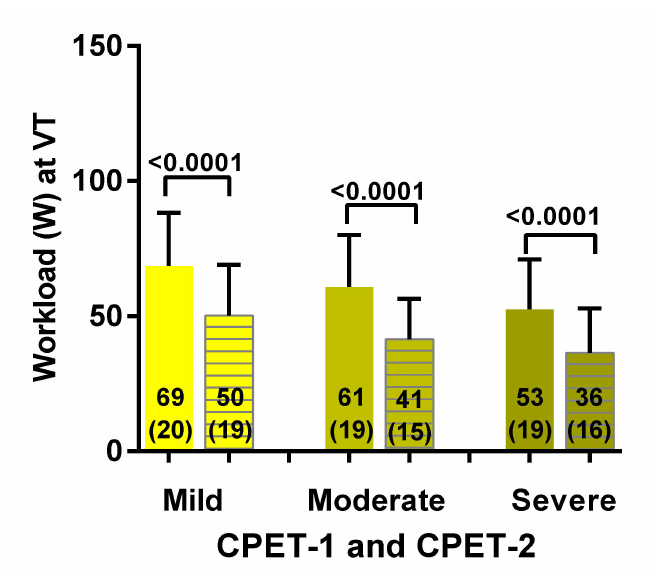
Figure 4. Workload at the ventilatory threshold for both CPET-1 and CPET-2 for mild, moderate and severe ME / CFS patients. CPET: cardiopulmonary exercise test; VT: ventilatory (or anaerobic) threshold. For between group comparisons see the result section. CPET-1 is presented by a solid bar and CPET-2 is represented by a lined bar.